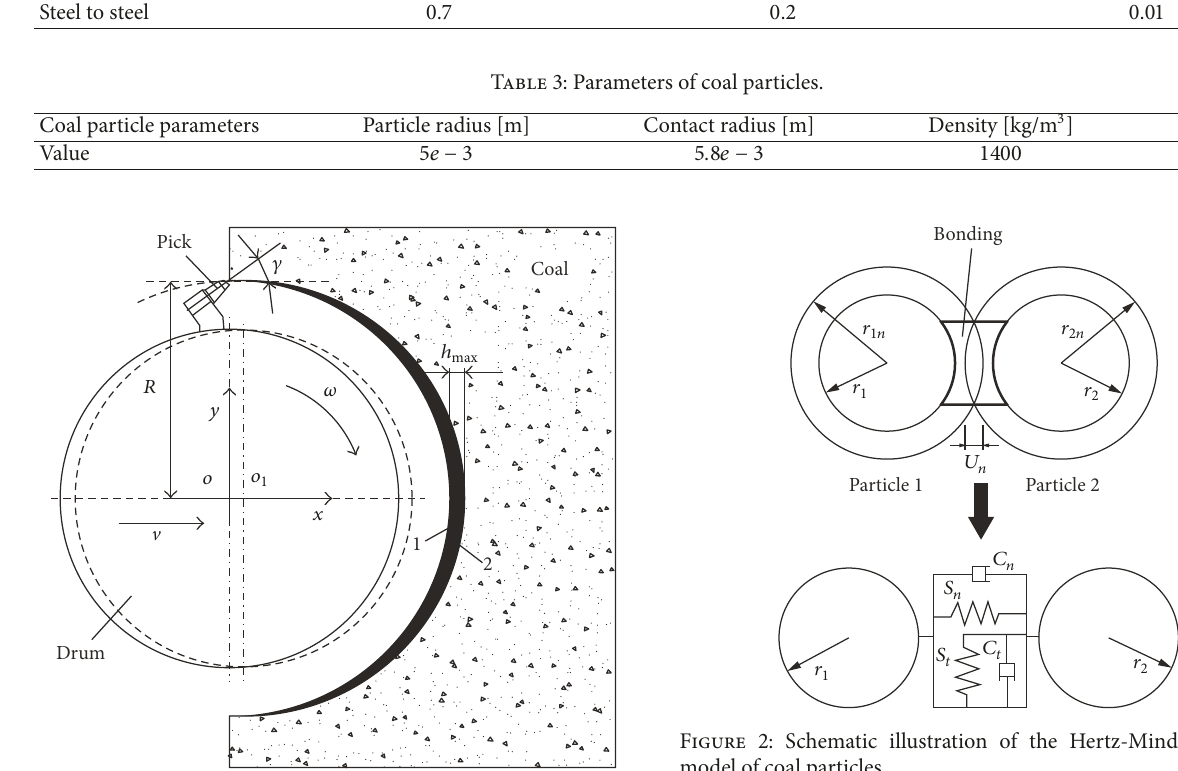
Figure 1: The diagram of conical pick cutting coal progress.